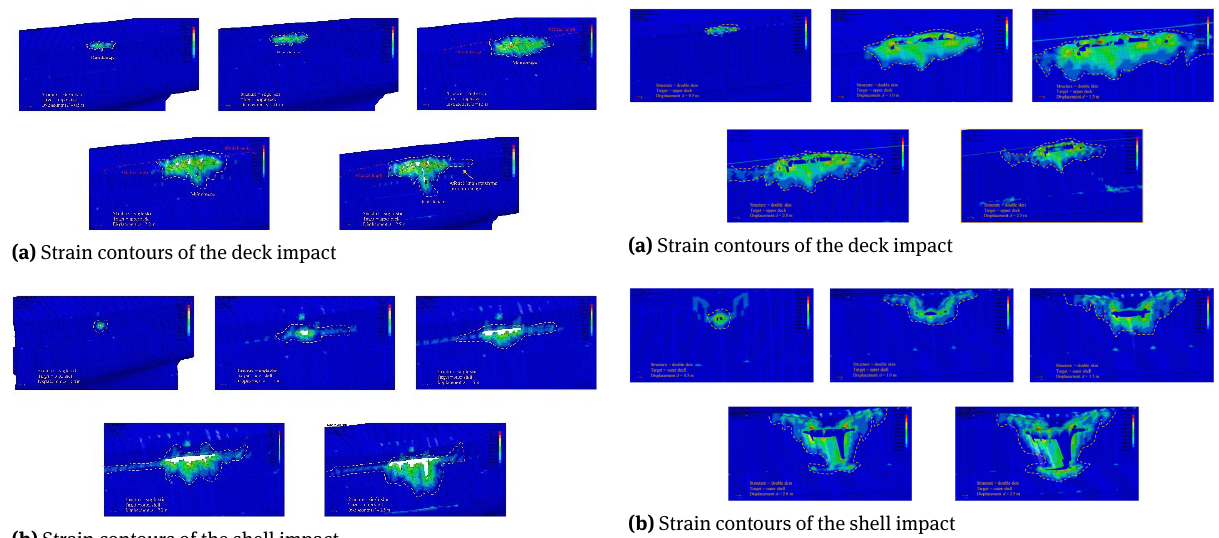
Figure 8: Summary of progressive failure on the